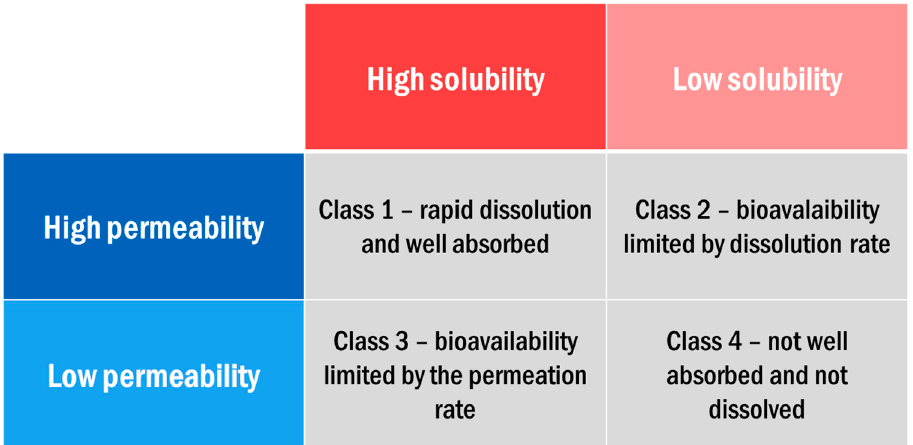
Figure 1. BCS classification system for orally administered drugs (modified and reprinted with permission from [14], Elsevier, 2012).